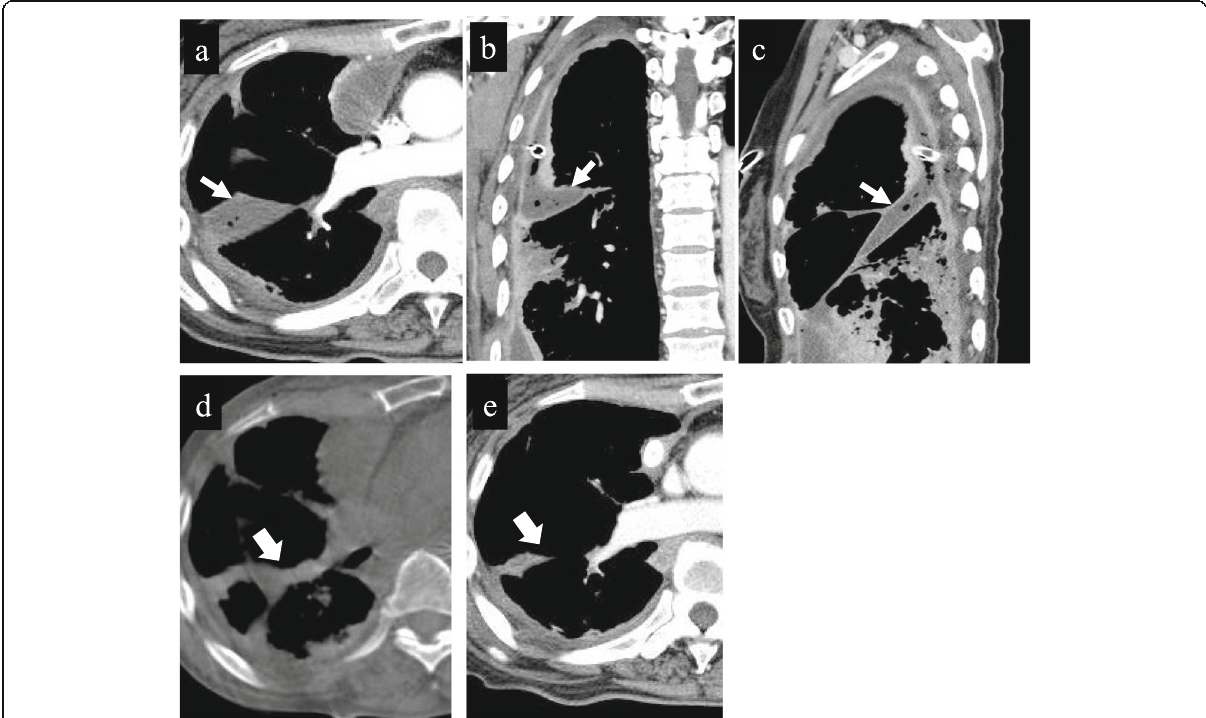
Fig. 3 Cavity II: This cavity was present from outside of the right upper lobe to the interlobar space between upper and lower lobes, in which a chest drainage tube has been inserted. Axial view ( a ), coronal view ( b ), and sagittal view ( c ) of chest CT findings at admission. Preoperative CT shows empyema cavity with some air bubbles and thickened peel ( c ). Intraoperative CBCT after initial debridement shows insufficiently dissected cavity ( d , arrow). Additional debridement resulted in successful shrinkage of the empyema cavity 2 weeks postoperatively ( e , arrow)